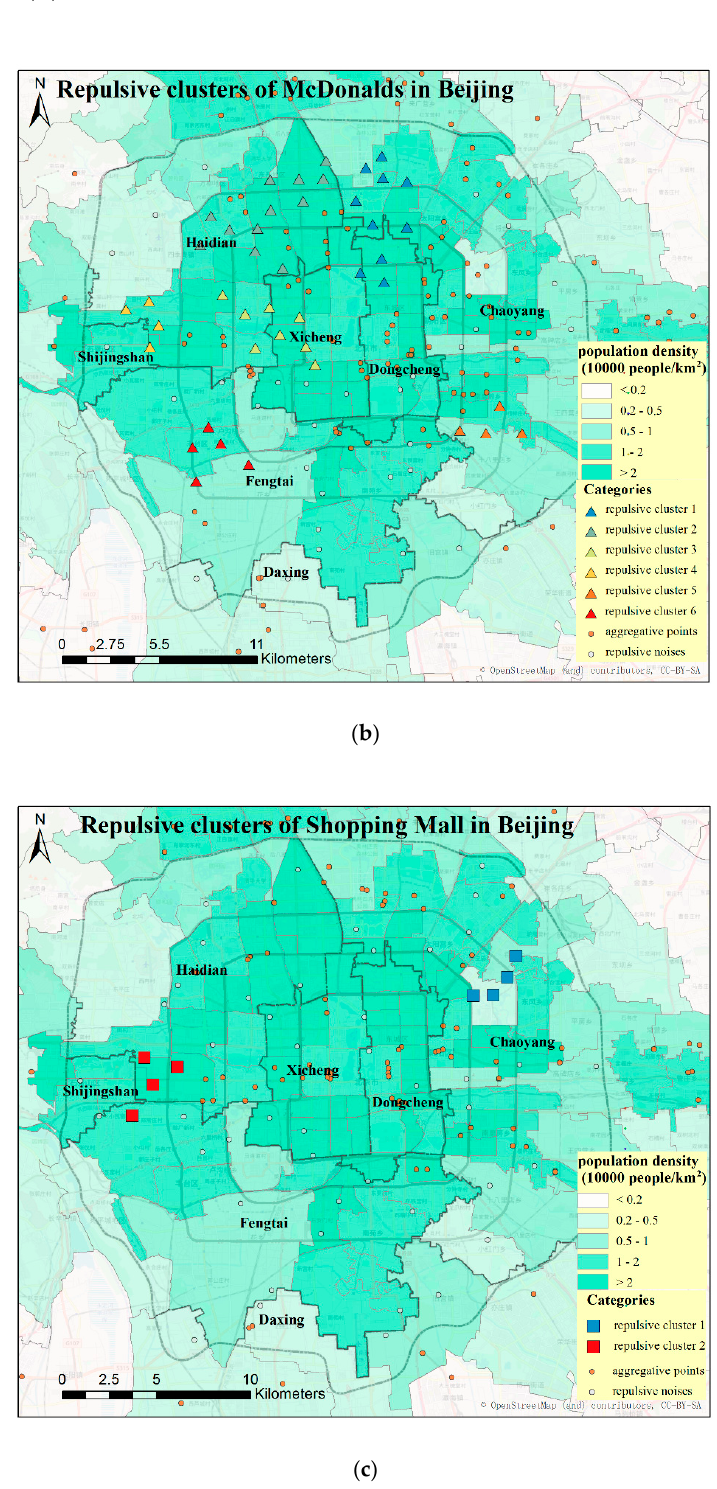
Figure 13. Repulsive clusters of three types of point of interest (POIs) in Beijing. ( a ) Distribution of KFC; ( b ) distribution of McDonalds; and ( c ) distribution of shopping malls.